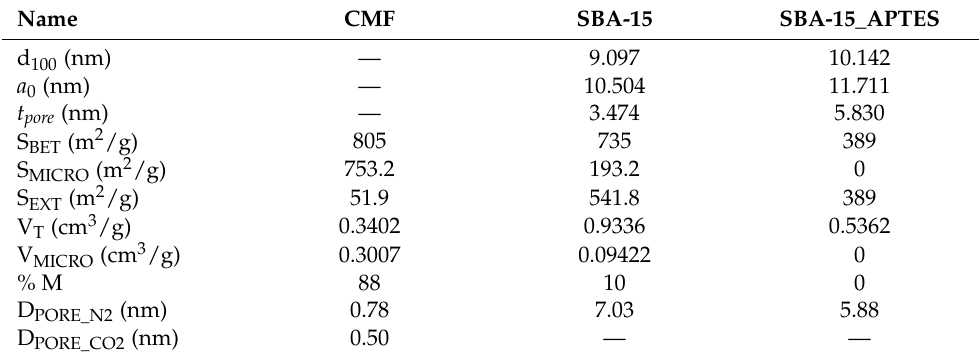
Figure 3. Powder XRD diffraction patterns of micro-mesoporous materials. Table 1. Textural properties of SBA-15, SBA-15_APTES, and carbon microfibers